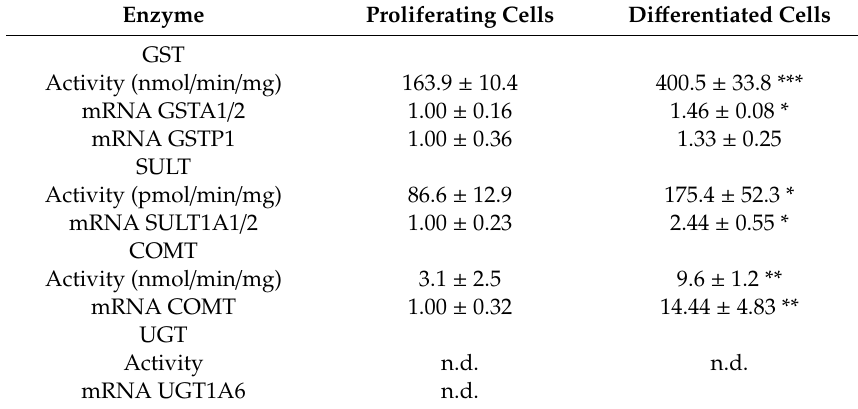
Table 2. Specific activity and mRNA expression of phase II drug-metabolizing enzymes (DMEs) in proliferating and di ff erentiated CaCo-2